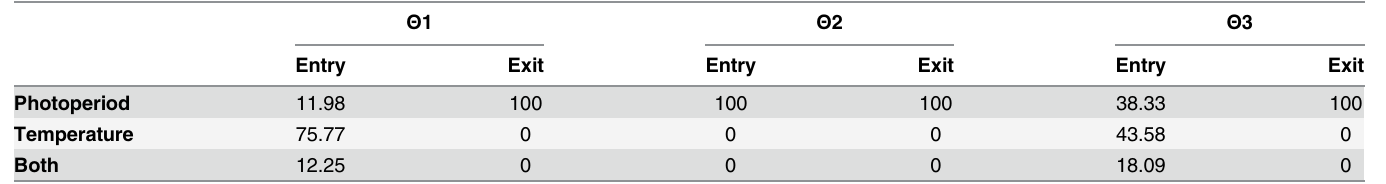
Table 3. Environmental dependency of diapause control as predicted by Θ 1, Θ 2 and Θ 3. The numbers are percentages over all entry or exit events encountered during the six years of